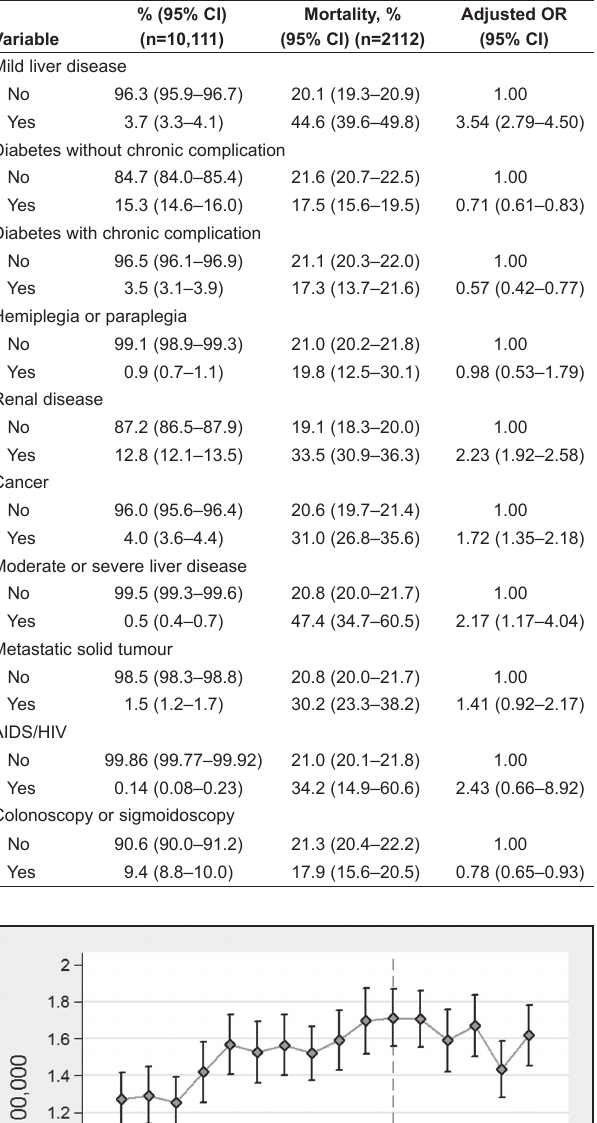
TAbLe 1 Predictors of in-hospital mortality in patients who underwent colectomy for ischemic colitis between 1993 and 2008